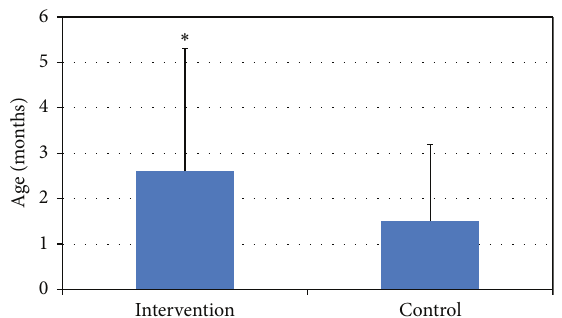
Figure 3: Age of infant at introduction of food/drink other than breast milk. ∗ 𝑝 < 0.051 . 𝑛 = 82 (control = 37, intervention = 45), considering only caregivers who ever